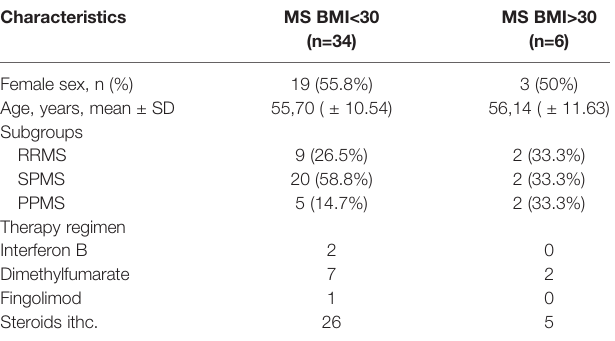
TABLE 1 | MS patient characteristics.